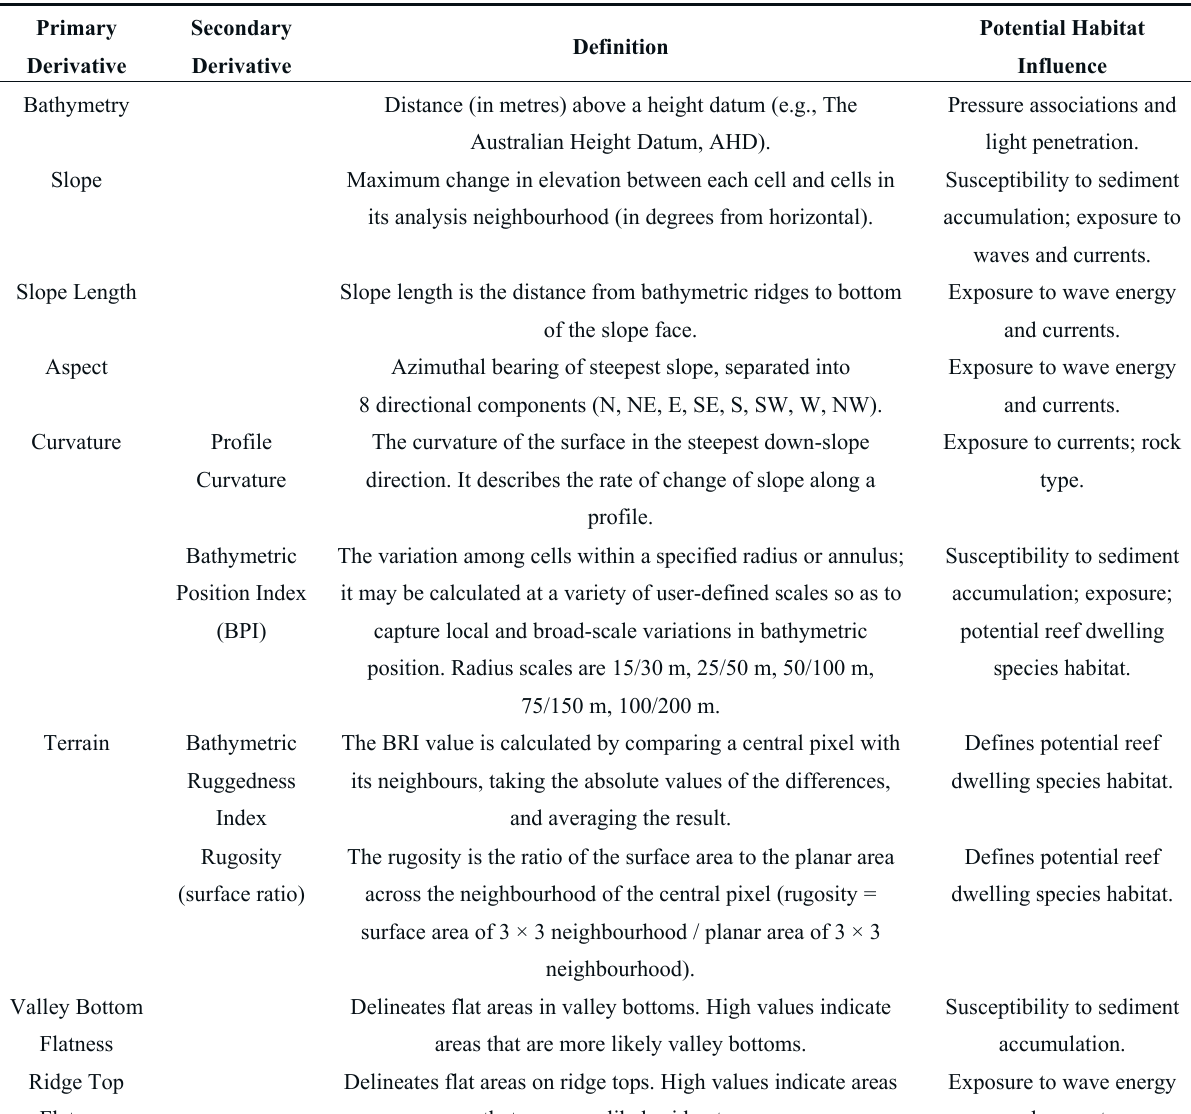
Table 1. Derivative products from the LiDAR dataset with definitions and possible influence on